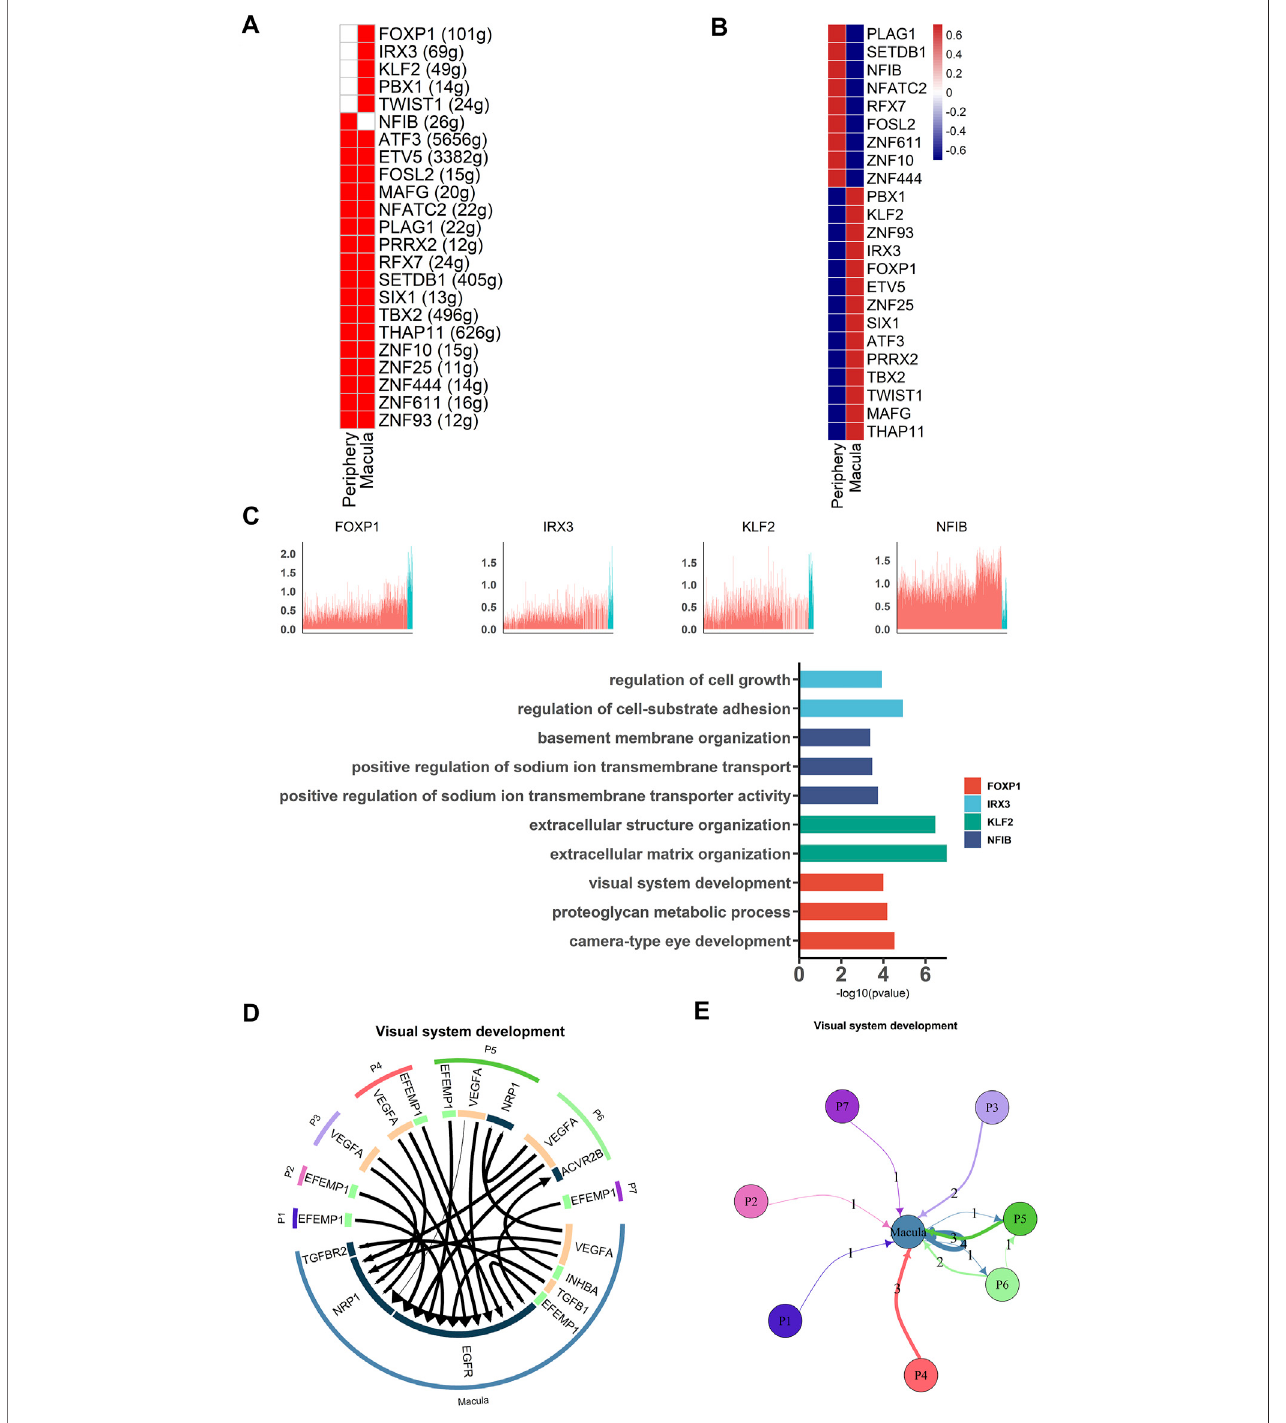
FIGURE 4 | Different gene expression patterns between macular and peripheral RPE (A). SCENIC results for the macular RPE and peripheral RPE. Heatmap showing the active and expressed transcription factors in each cell cluster. The states of the transcription factors in each cell class are indicated in red (active) and white (inactive) (B). Heatmap shows the average expression of active transcription factors in each cell cluster. The expression level is indicated by the color level; red indicates high expression, and blue indicates low expression (C). Expression of speci fi c highly expressed transcription factors and GO functional analysis of their corresponding target genes. The upper part of the fi gure represents the expression of transcription factors, and the lower part of the fi gure represents the functional annotation of target genes regulated by transcription factors (D). Analysis of cell communication between macular RPE and peripheral RPE. The visual system development of the hRPE among the top 20 ligand-receptor pairs (E). Connections between the peripheral RPE subpopulations and the macular RPE cluster of ligand- receptor pairs of the visual development system.